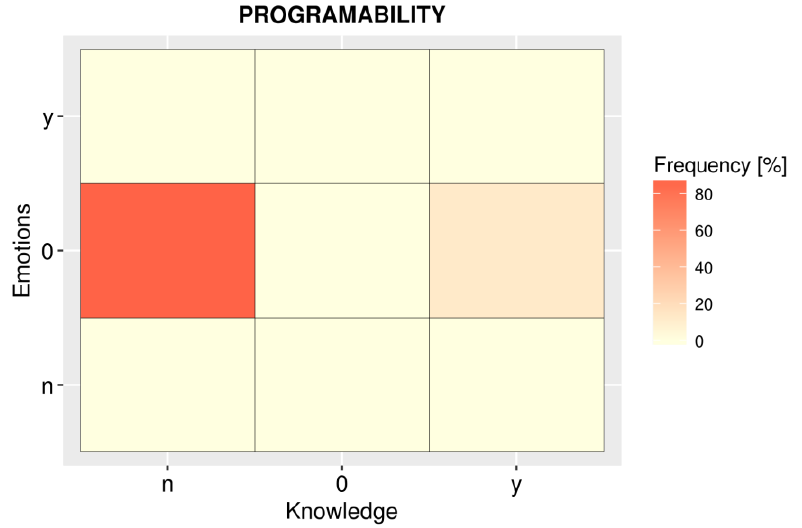
Figure 7. Frequency of responses compared between the knowledge and emotions dimensions— programmability theme.